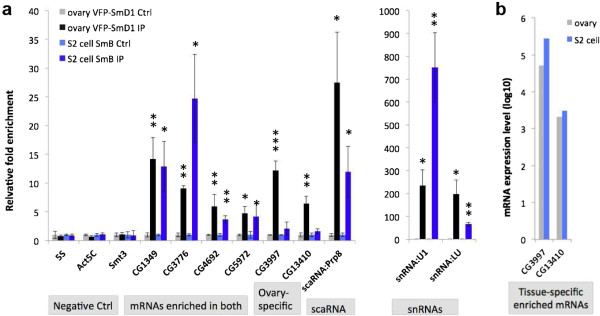
RNA-Sm association is cell type-specific and not due to re-assortment. (a) RIP-qRT-PCR in da-Gal4 VFP-SmD1 fly ovary (anti-GFP) and S2 cells (Y12). Negative controls (Ctrl) used are 5S rRNA, Act5C and Smt3. CG9042 (Gapdh) is used as the normalization standard. snRNAs are shown separately due to the difference in scale. (b) mRNAs associated with Sm proteins in ovaries but not in S2 cells are expressed in S2 cells. t-Test for significance between IP and Ctrl: *P < 0.05, **P < 0.01, ***P < 0.001. Error bars show standard deviation.